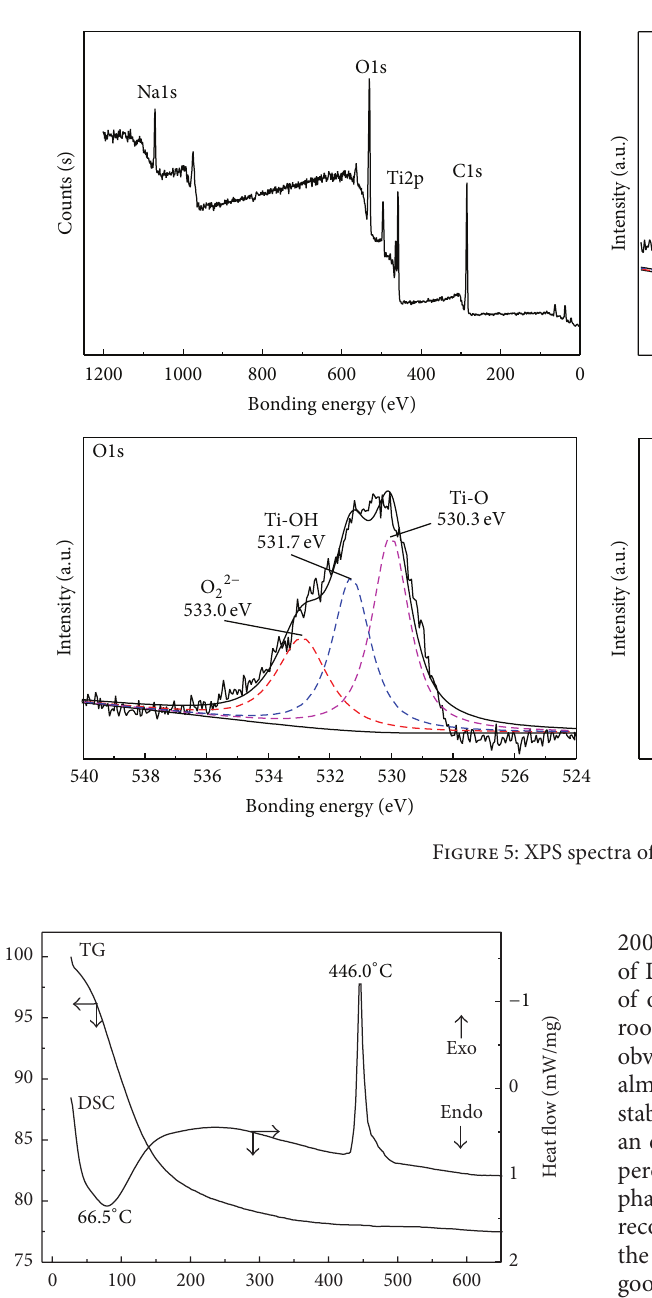
Figure 6: TG-DSC curves of